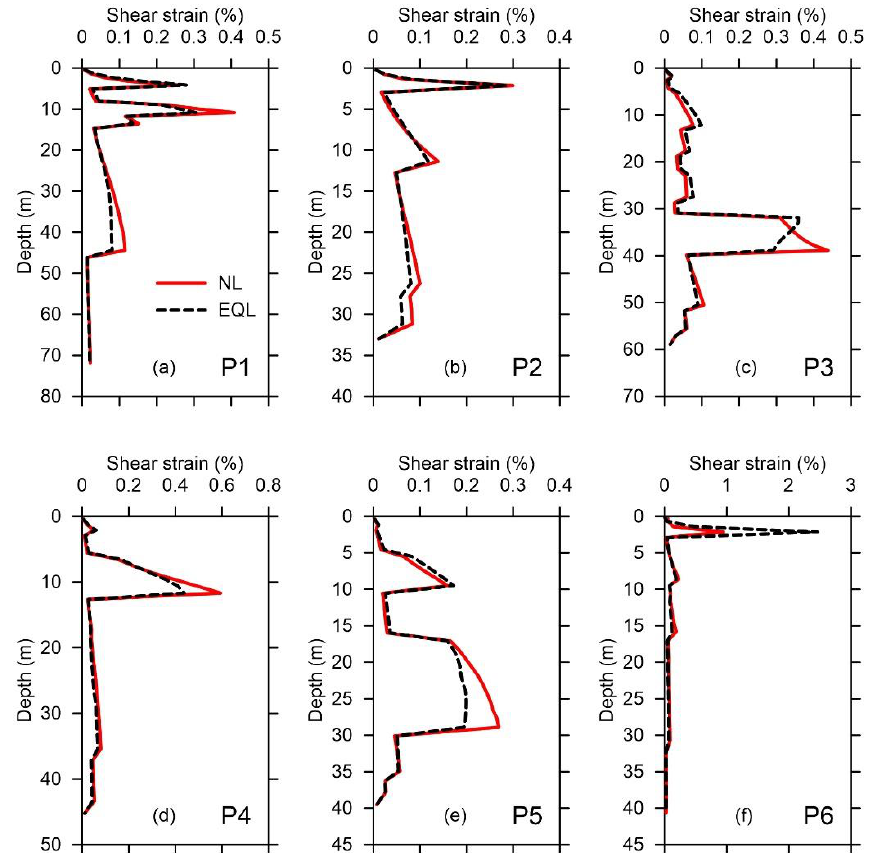
Figure 10. Maximum shear strain of soil profiles: ( a – f ) P1 – P6.